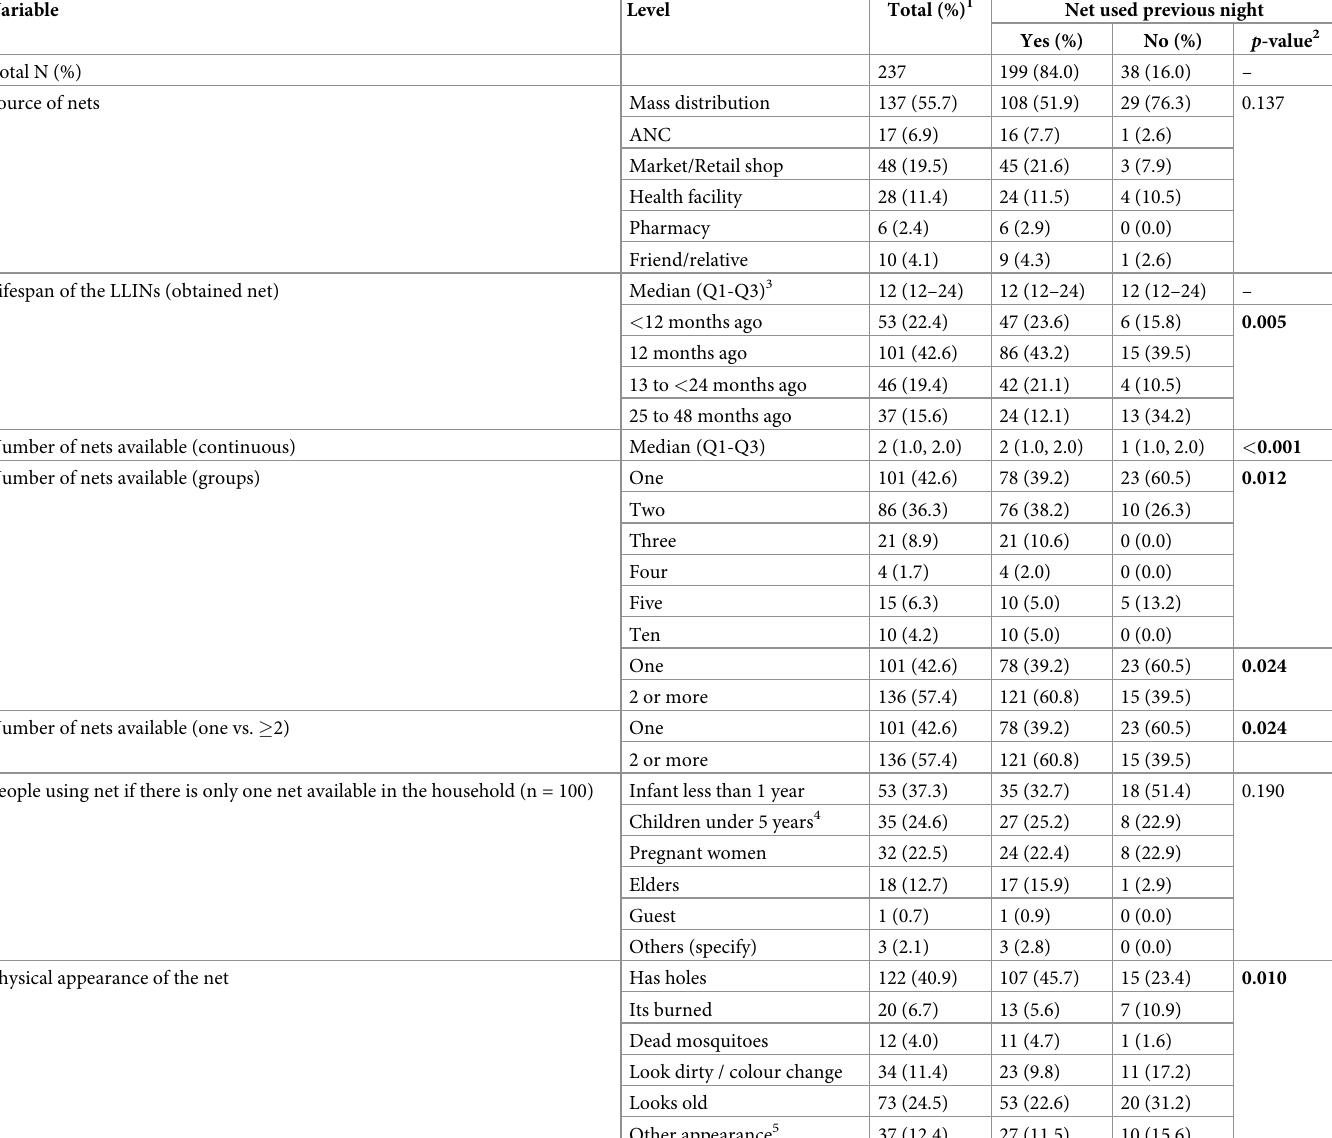
Table 5. Physical appearance, variations by source and patterns of utilization LLIN amongst household members the night prior to the survey in Mogadishu dis- tricts, Somalia, 2021. Variable